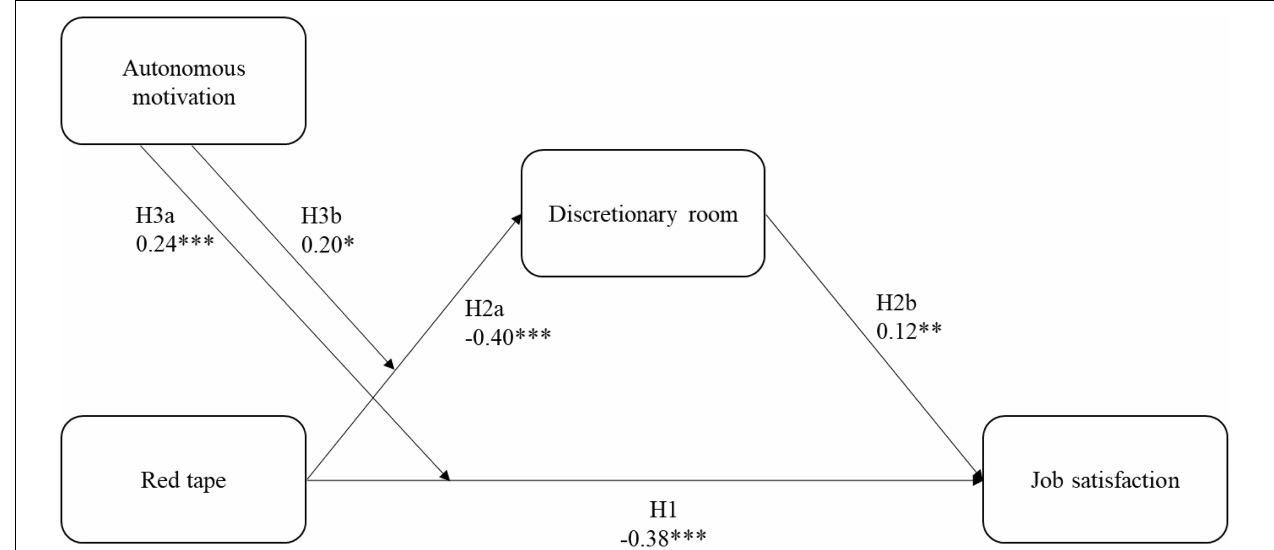
FIGURE 1 | Results of the hierarchical regression analyses of the moderated mediation model. Participants’ age, gender, and span of control are included as control variables. N = 247; ∗ p < 0.05, ∗∗ p < 0.01, ∗∗∗ p < 0.001.